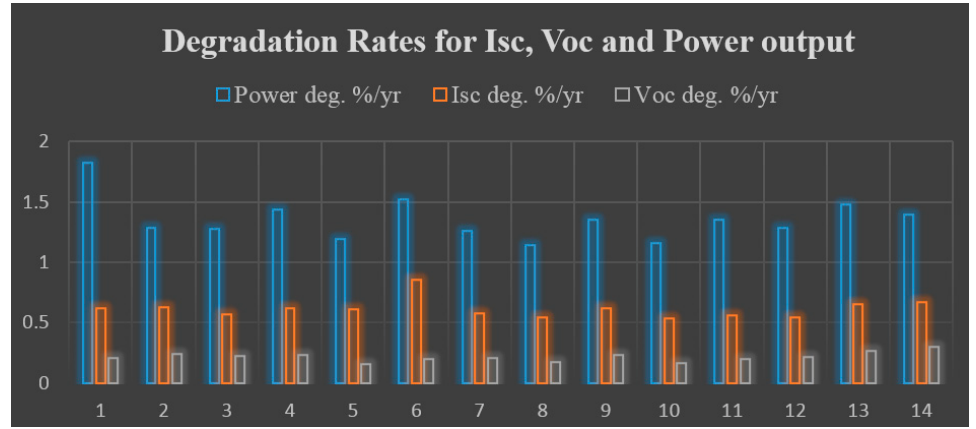
Figure 10. Degradation rates of 14 PV modules.